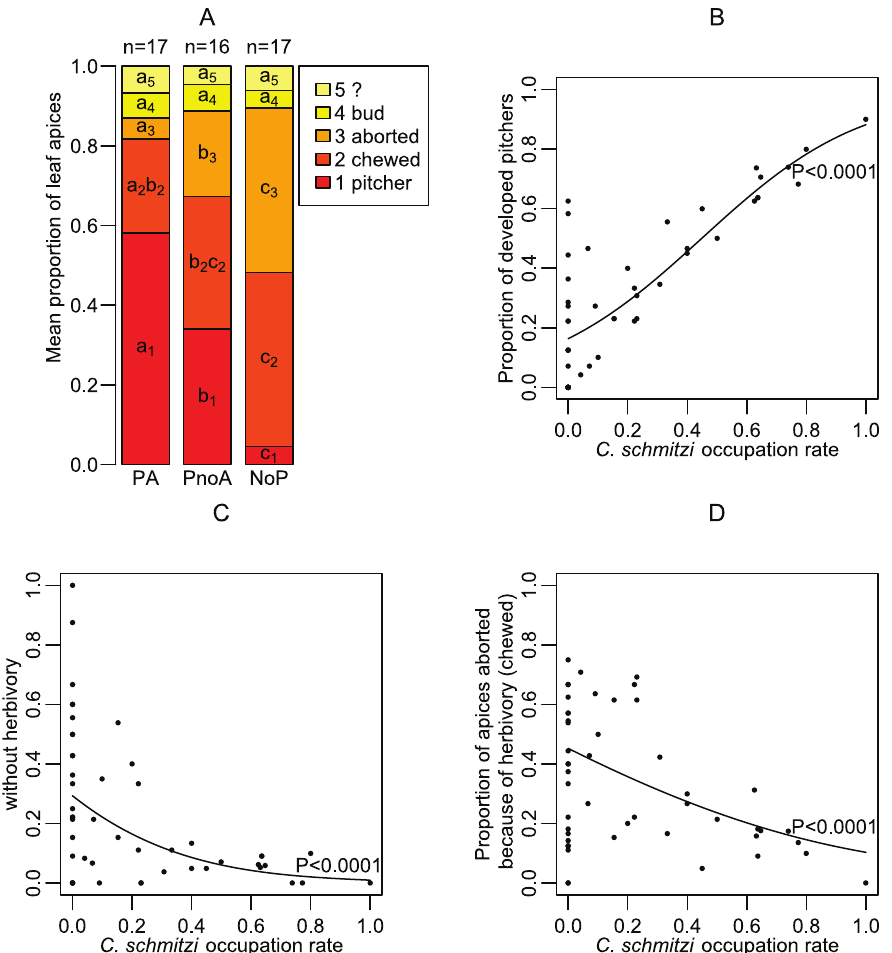
Figure 3. Positive effect ofCamponotusschmitzi on pitcher production. ( a ) Mean proportions of apices that have remained buds, aborted, been chewed, developed into a pitcher or with unknown fate (?: tendril cut) compared for PA, PnoA and NoP plants. ‘‘Pitcher’’ refers to both living and dead pitchers (e.g., in NoP plants, the latter). ( b ) Proportion of functional pitchers as a function of C. schmitzi occupation rate. The line represents the estimated probability of an apex forming a pitcher, as predicted by logistic regression. ( c ) Proportion of apices that have aborted without herbivory as a function of C. schmitzi occupation rate. ( d ) Proportion of apices that have aborted because of herbivory as a function of C. schmitzi occupation rate.